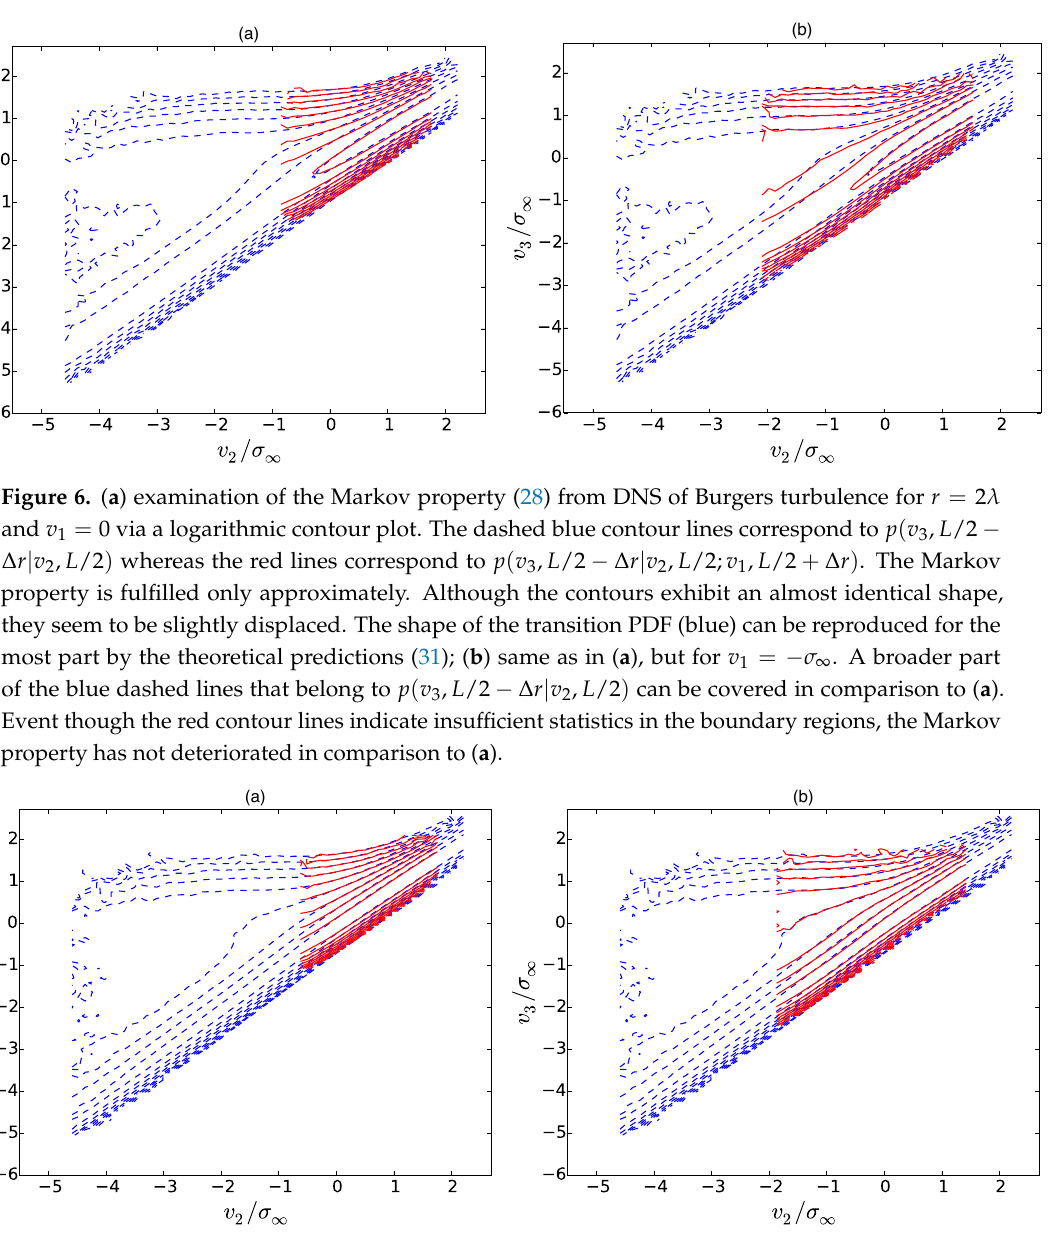
Figure 7. ( a ) examination of the Markov property (28) from DNS of Burgers turbulence for ∆ r = λ and v 1 = 0. The Markov property seems to hold quite well for this set of parameters; ( b ) same as in ( a ), but for v 1 = − σ ∞ . A broader part of the blue dashed lines that belong to p ( v 3 , L /2 − ∆ r | v 2 , L /2 ) The Markov property has not deteriorated in comparison to ( a